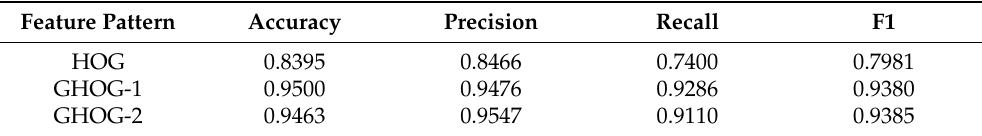
Table 2. The performance indices for the HOG and GHOG feature patterns. GHOG-1 and GHOG-2 correspond to two different Gamma